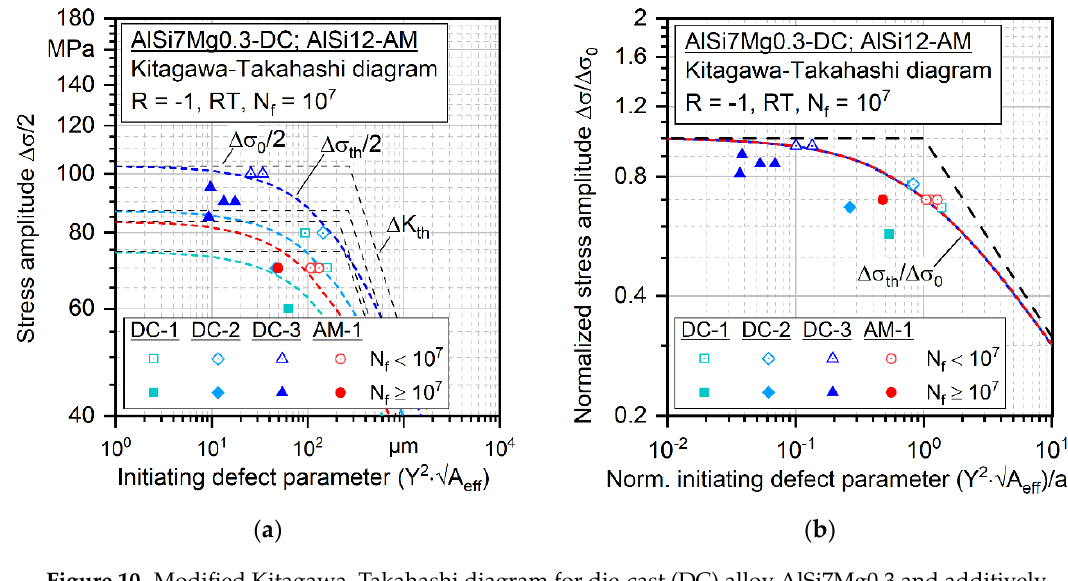
Figure 10. Modified Kitagawa–Takahashi diagram for die-cast (DC) alloy AlSi7Mg0.3 and additively manufactured (AM) alloy AlSi12 ( a ) for specific batches ( ∆ σ /2 = σ a ) and ( b ) normalized to batch-specific intrinsic material fatigue limit ∆ σ 0 and crack length a 0